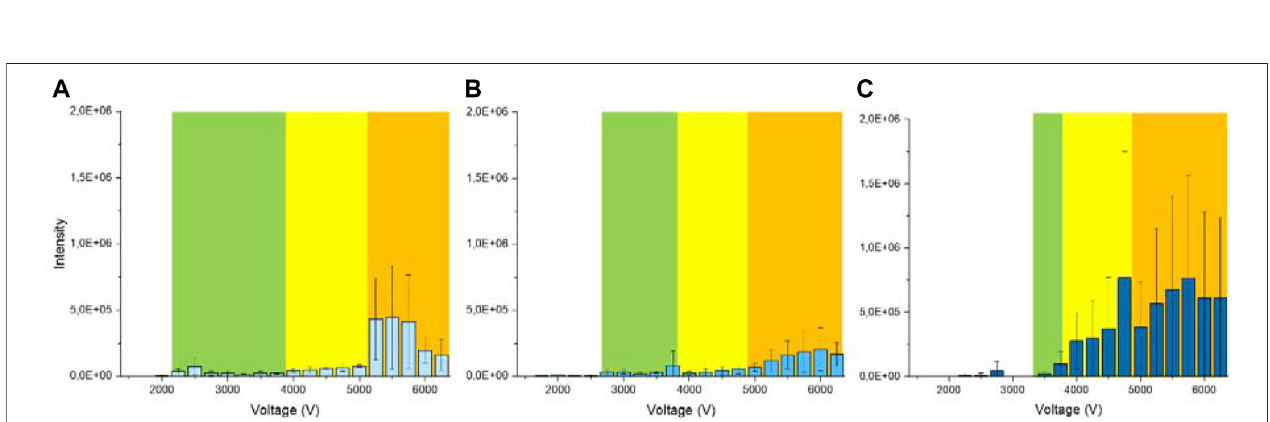
FIGURE 2 | PSI MS signal intensity of 50 μ g/ml trimethoprim loaded onto the (A) Whatman grade 40 fi lter paper, (B) grade 3 MM chromatography paper, and (C) grade 17 chromatography paper with varying spray voltages. The background colors indicate the spray modes: green, yellow, and orange corresponding to the single cone-jet, multi-jet, and rim-jet modes,